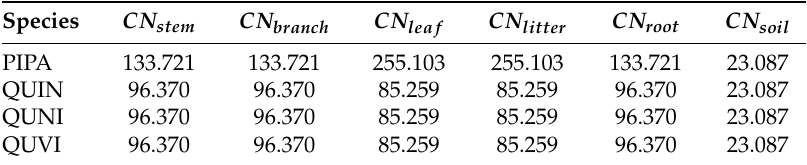
Table A22. Species C:N ratio